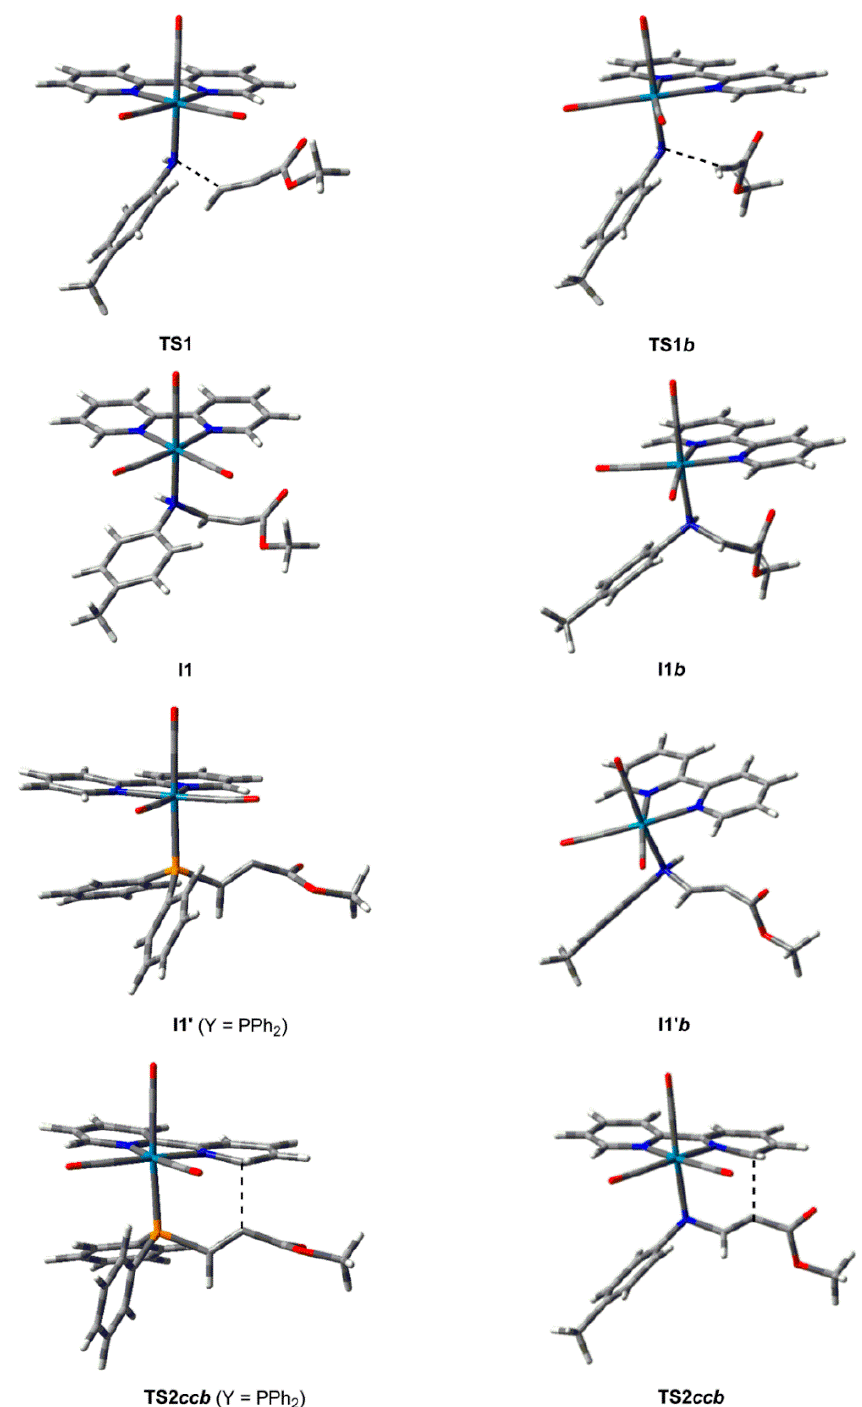
Figure 1. B3LYP optimized structures of some species located for the reaction of the complex [Re(NH p Tol)(CO) 3 (bipy)] towards HMAD. B3LYP optimized structures of I1 ′ and TS2 ccb for Y = PPh 2 are also given for comparison purposes.